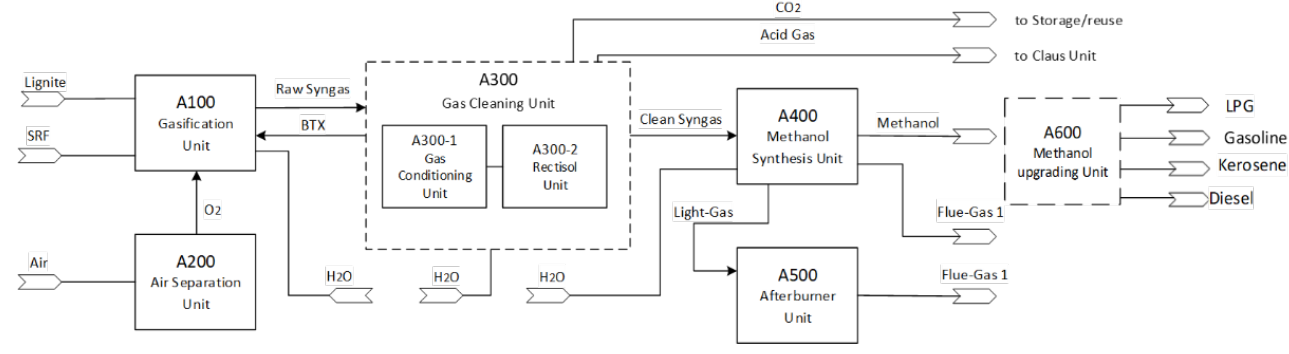
Figure 1. Synthetic methanol production block flow diagram.